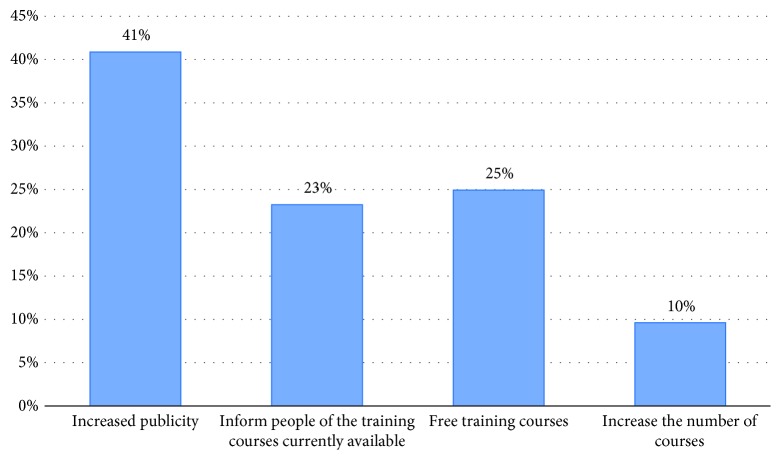
The effective method in students' opinion to increase public awareness about CPR.